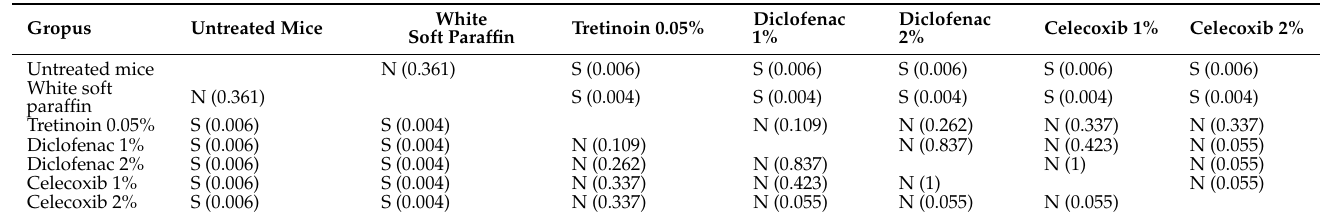
Table 2. Multiple statistical comparisons regarding orthokeratosis using Kruskal–Wallis test.